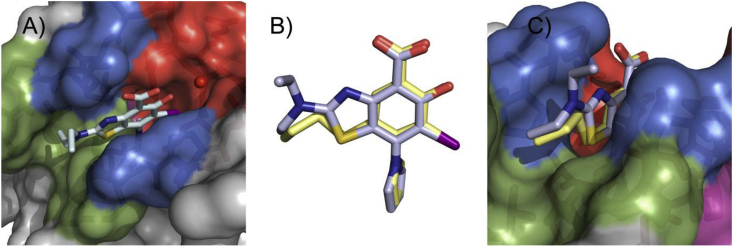
Crystal structure of MB710 bound to Y220C. A) Top view of the binding pocket with bound MB710 shown as a light blue stick model. The conserved structural water molecule interacting with MB710 is shown as a red sphere. B) Superimposed structures of bound MB710 (light blue sticks) and 60 (light yellow sticks) shows the conservation of the ligand binding mode. C) The terminal methyl group of MB710 (light yellow) occupies a nearly identical position to that of 60 (light blue), validating the cyclization strategy.